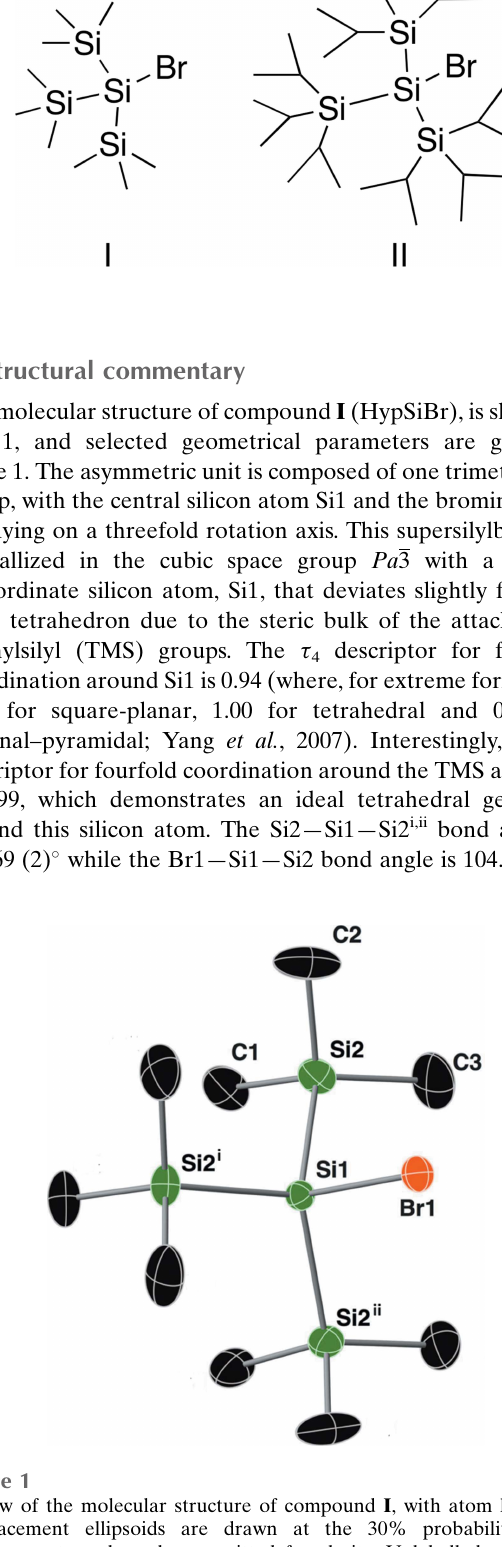
Figure 2 A view of the molecular structure of compound II , with atom labelling. Displacement ellipsoids are drawn at the 30% probability level, and all hydrogen atoms have been omitted for clarity.